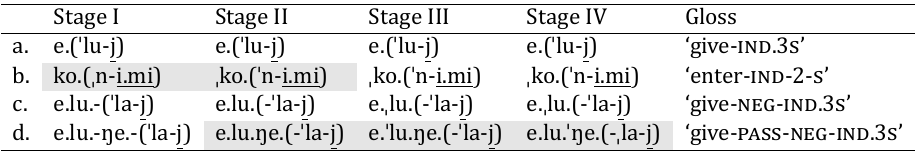
Table 22: Changes in stem stress in verbs (feet in parenthesis, OFI underlined, second- ary stress marks denote ‘demotion’ of stress — key changes in